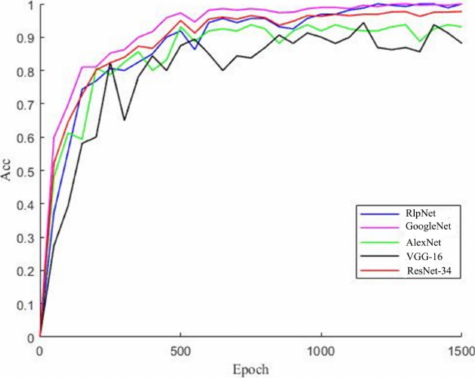
Figure 7. Training accuracy of the different